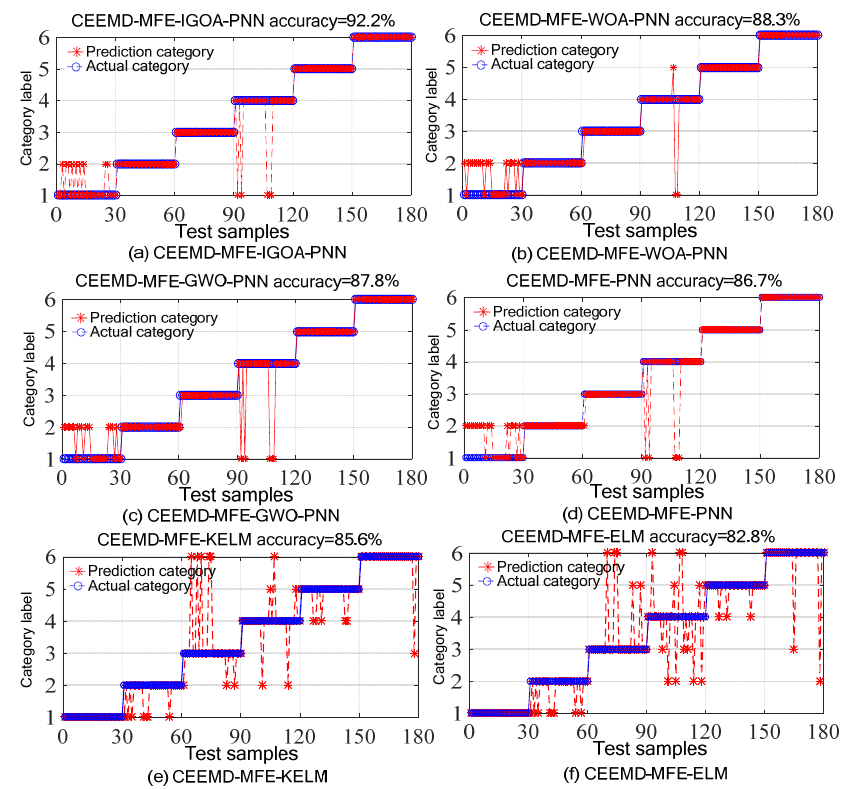
Figure 15. Identification results of different methods.